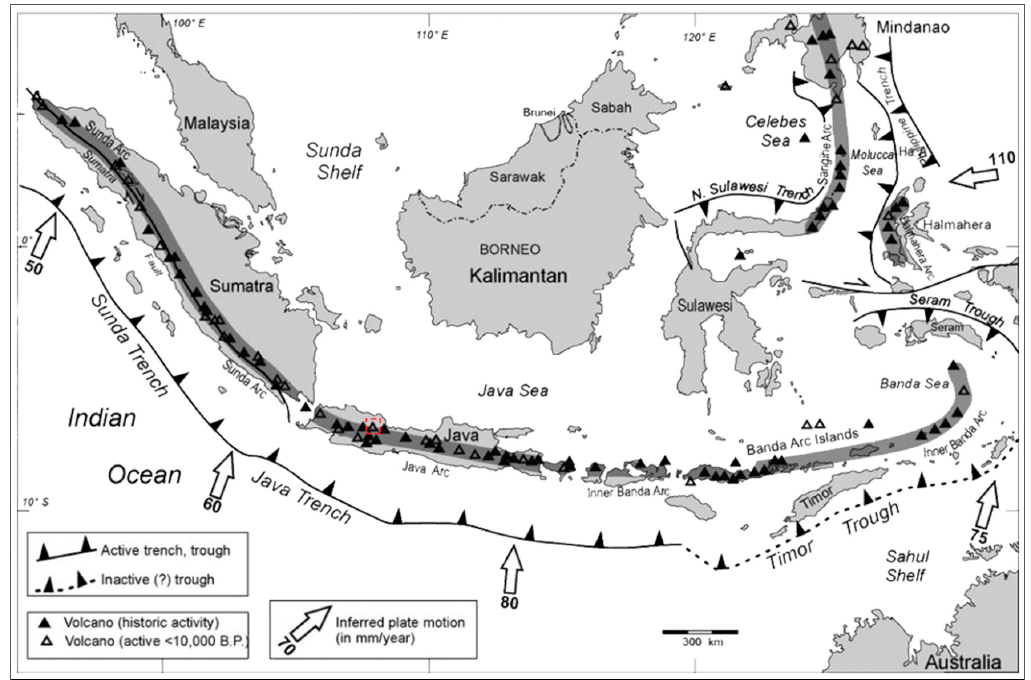
Figure 1. The geographical map shows the regional tectonic setting and presence of active volcanoes in Indonesia [12], as well as the location of the research area, indicated by the red dashed polygon.